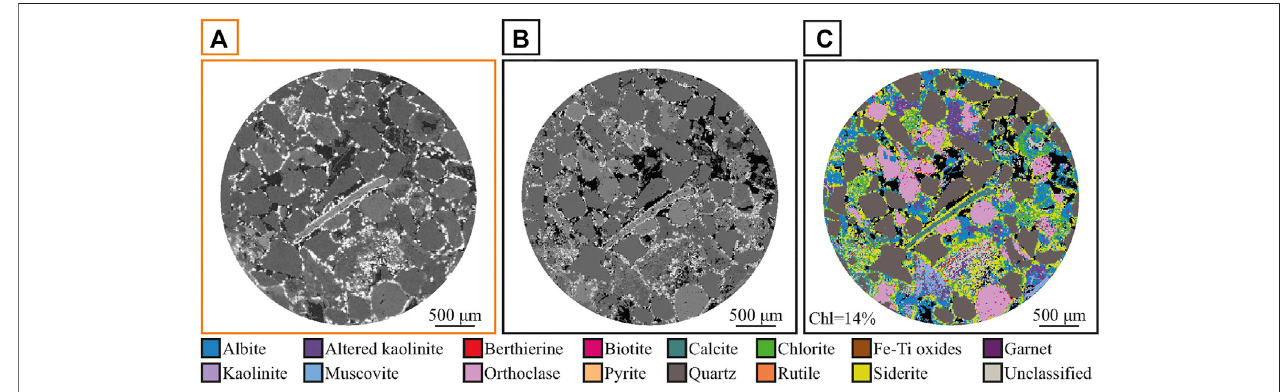
FIGURE 2 | Registered XCT and SEM slice with associated AQM analysis of sample S6 after being hydrothermally treated up to 250 ° C. (A) 2D slice through 3D grayscaleXCTdata. (B) RegisteredSEMslice.VariationsingrainandporesizeintheimagesareduetodamageduringthepolishedsectionpreparationforSEManalysis. (C) In-situ mineral map. Where Chl =